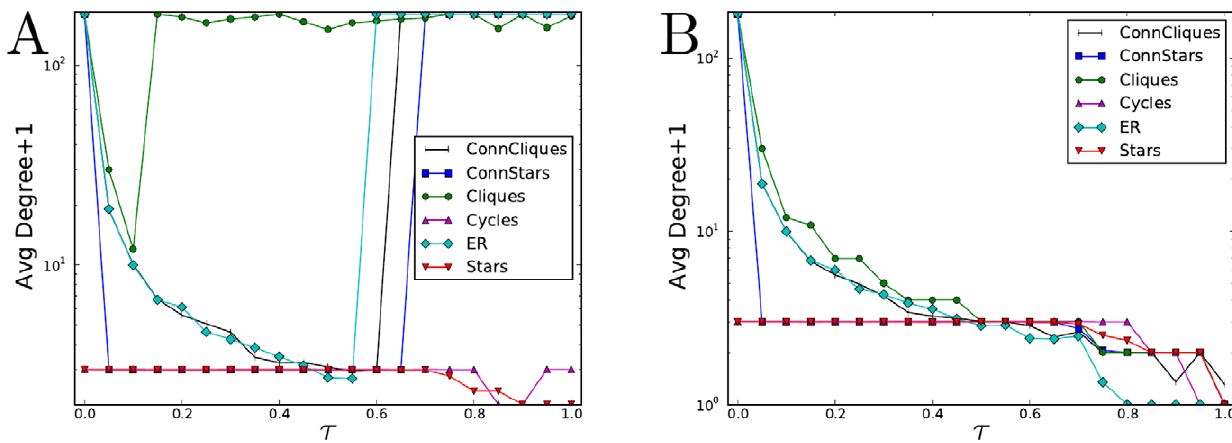
Figure 5. Average degree in the optimal configuration of each design. At r ~ 0 : 49 (A) the optimization prefers networks that have high efficiency while at r ~ 0 : 51 (B) the preference is for resilience. In (B) the average degree diminishes monotonically to compensate for increasing cascade risk. In (A) most designs have a threshold t at which they jump back to a completely-connected graph because structural cascade resilience becomes too expensive in terms of efficiency.